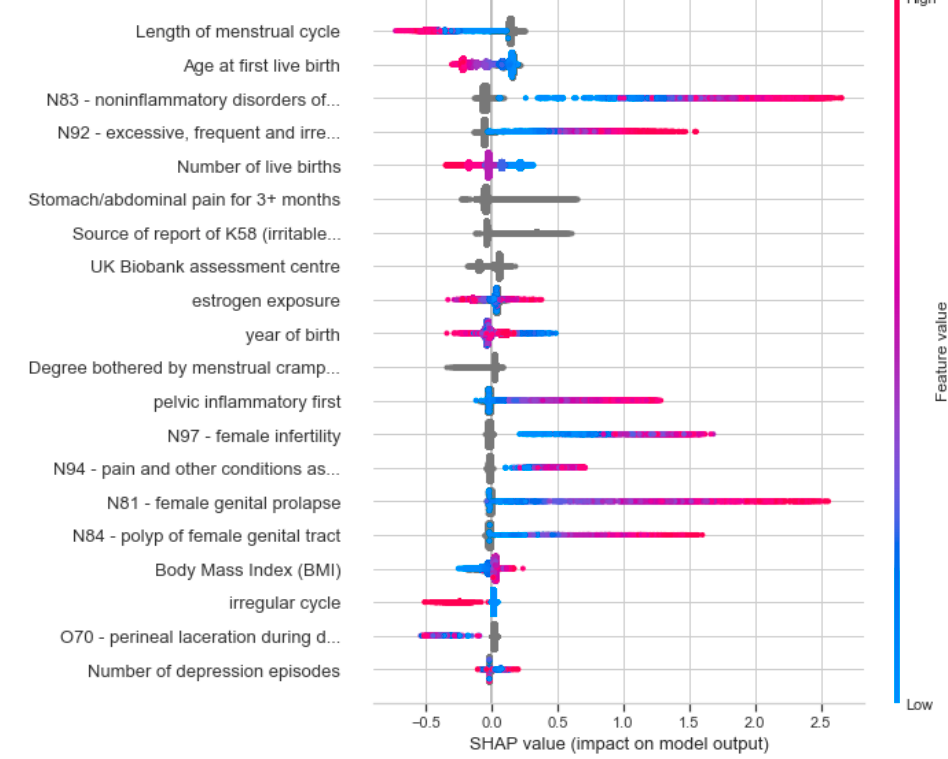
Figure 6. Top 20 features from the combined model using SHAP (an explainable AI tool). Variables are ranked in descending order of their SHAP value, where the most informative feature is at the top. The values reported show the contribution of each of the features according to the impact of that feature on the model outcome (i.e., endometriosis). Each dot in the plot represents a subject patient’s feature value for that variable (vertical axis). Color reflects the scale of the feature’s value. Color shows whether that variable is high (red) or low (blue) for that observation. Gray depicts no data or a categorical feature.